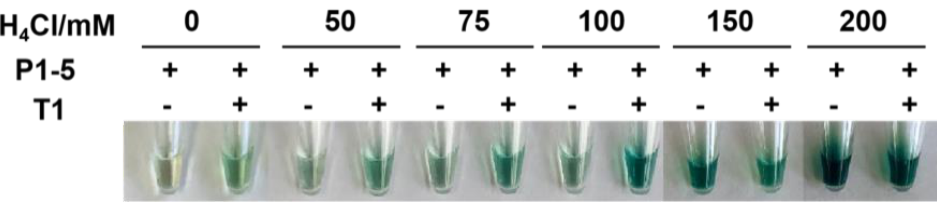
Figure 1. Photograph of colorimetric detection of target T1 by probe P1-5 at different concentrations of ammonium ions. Conditions: 2 μM of each of the probe or target, 20 mM MgCl 2 , 100 mM Tris- of ammonium ions. Conditions: 2 µ M of each of the probe or target, 20 mM MgCl 2 , 100 mM Tris-HCl HCl (pH 7.4), and 0 – 200 mM NH 4 Cl, as illustrated. (pH 7.4), and 0–200 mM NH 4 Cl, as